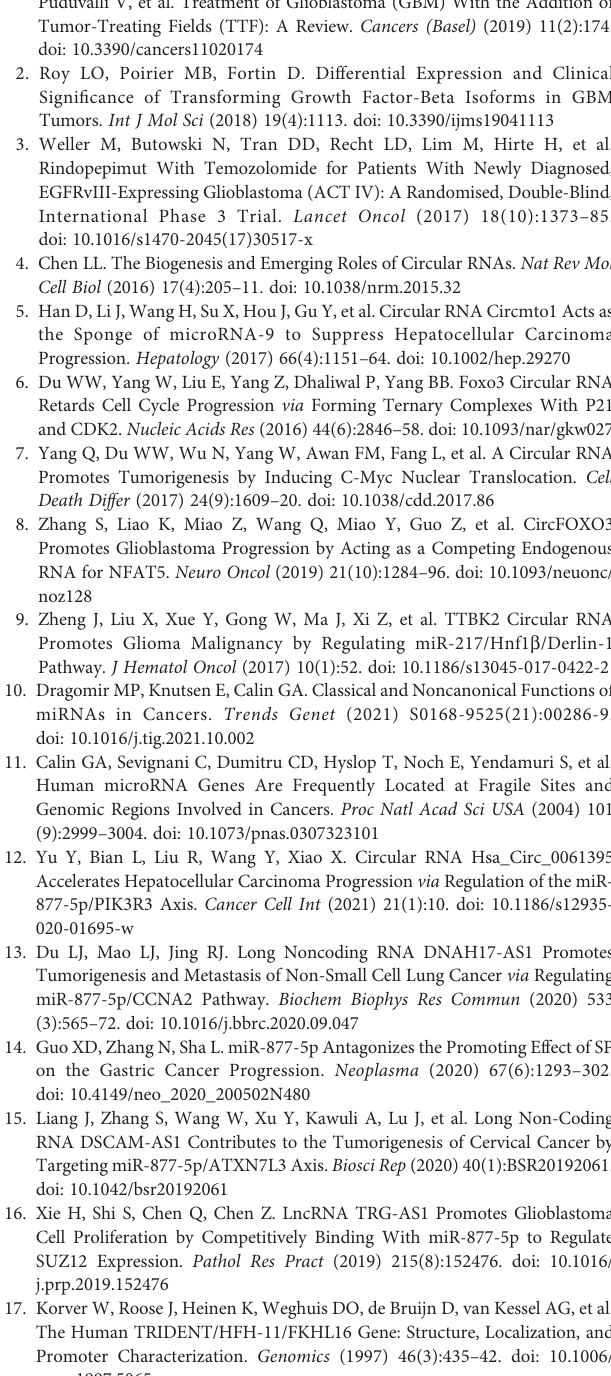
miR-877-5p inhibitor was reduced compared with those in the circPIK3C2A-KD group.Data are presented as the mean ± SEM of 3 independent experiments. Signi fi cant results are presented as *P < 0.05, **P < 0.01, ***P < 0.001, and ****P <